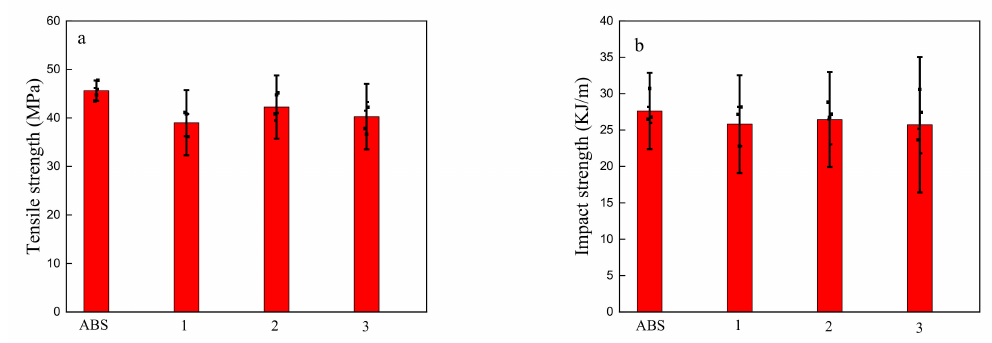
Figure 6. ( a ) Tensile strength and ( b ) impact strength of printed ABS / octyl-QDED.